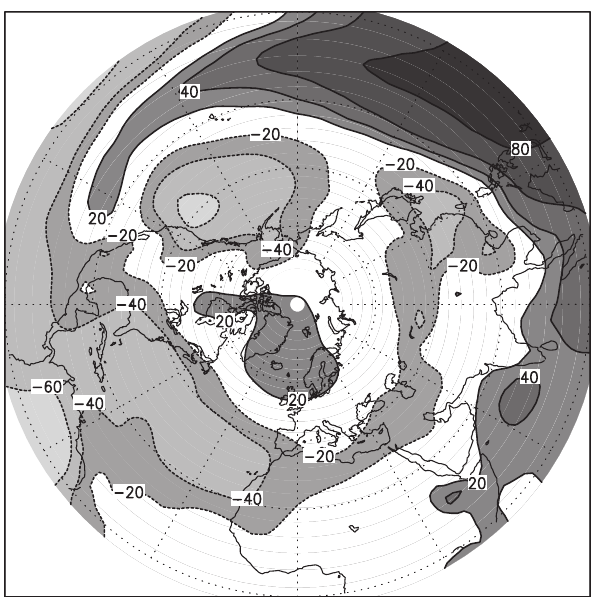
Fig. 8. Correlations (in %) between the tropical SST time series (fig. 7b) and model simulated MSLP on the Northern